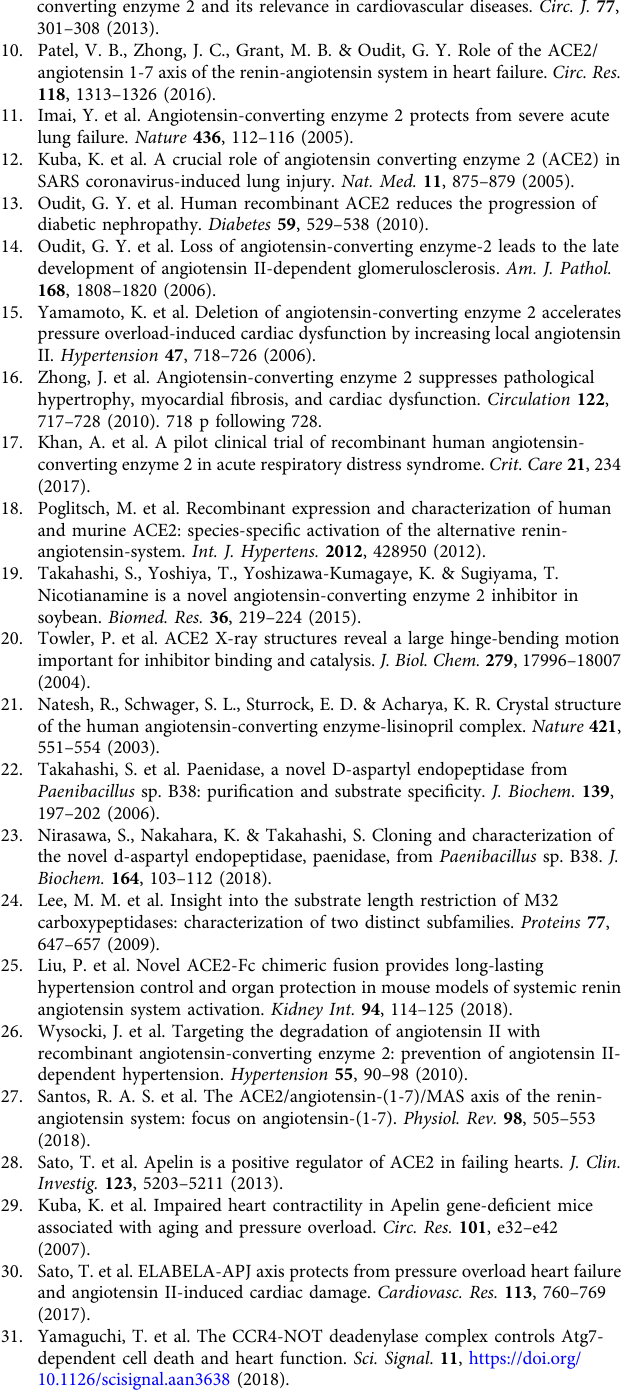
Supplementary Table 6. Real-time PCR was run in 96-well plates using a SYBR Premix ExTaq II (TAKARA) according to the instructions of the manufacturer. Relative gene expression levels were quanti fi ed by using the Thermal Cycler Dice Real Time System II software (TAKARA). Measurements of Ang II and Ang 1 – 7 in mouse plasma . Plasma Ang II and Ang 1 – 7 levels were measured with enzyme-linked immunosorbent assay (ELISA)